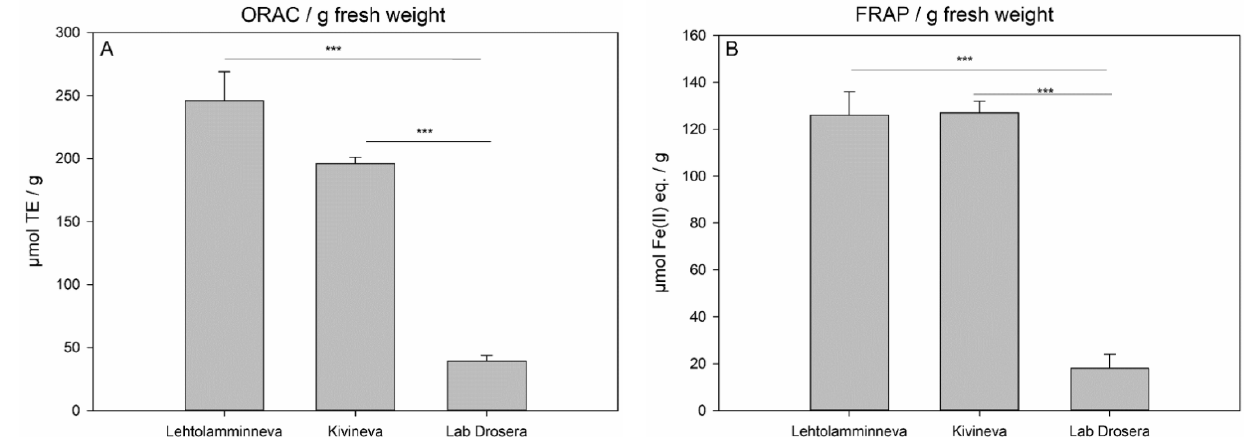
Figure 4. ( A ) ORAC and ( B ) FRAP activities (mean ± standard deviation, n = 3) of D. rotundifolia plants collected from Lehtolamminneva mire and Kivineva mire and lab-grown propagated D. rotundifolia biomass (Lab Drosera). TE = Trolox (vitamin E derivative) equivalent. One-way ANOVA test was used to assess the statistical significance of differences between Lab Drosera and mire grown samples (*** = p < 0.001).